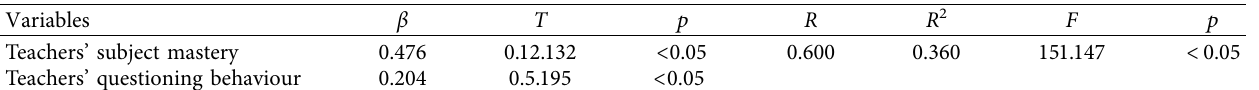
∗∗ Correlation is significant at the 0.05 level (3-tailed). Table 2: Multiple regressions showing the influence of teachers’ subject mastery and questioning behaviour on students’ achievement in English